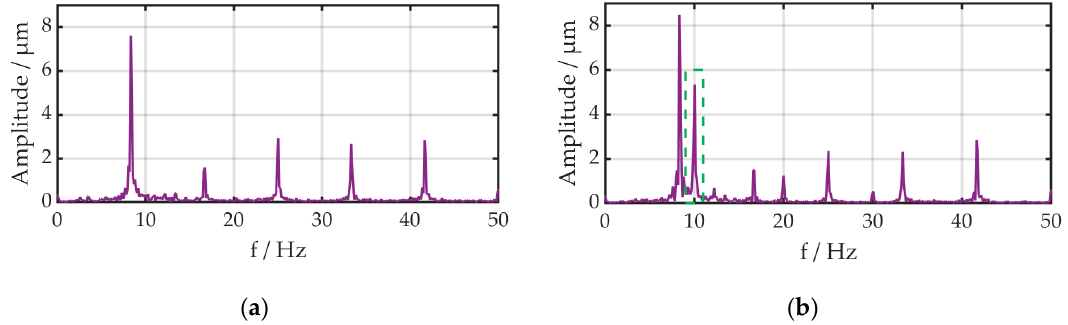
Figure 8. Measured displacement at the end of the of the rotating system ( a ) without switching field and ( b ) with switching field (sinus 10 Hz).